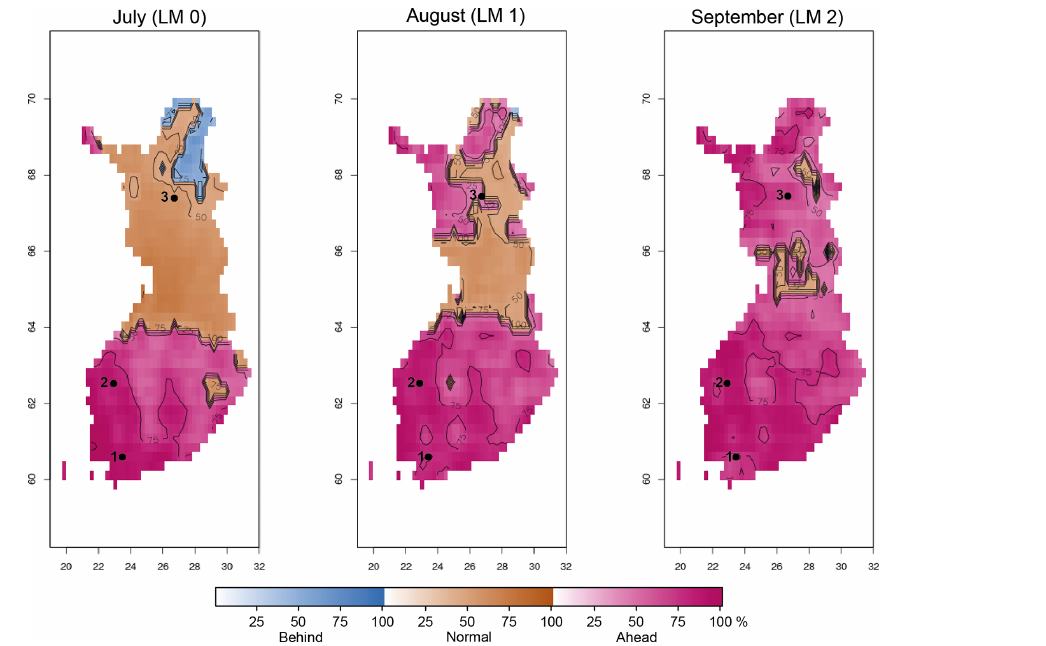
Figure 1. Seasonal climate outlook describing the development of growing season with lead months 0, 1 and 2 initialized in July 2019. Dots from maps mark the location of the reported stations (discussed in Sect. 3.3): 1 – Jokioinen, 2 – Seinäjoki and 3 –